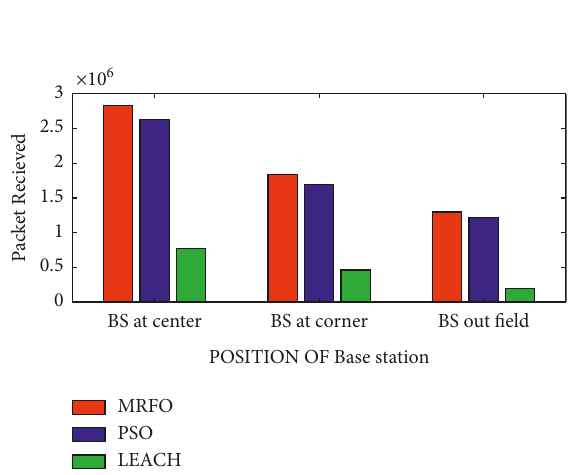
Figure 22: Number of packets received for 400-node network with 40 CHs.